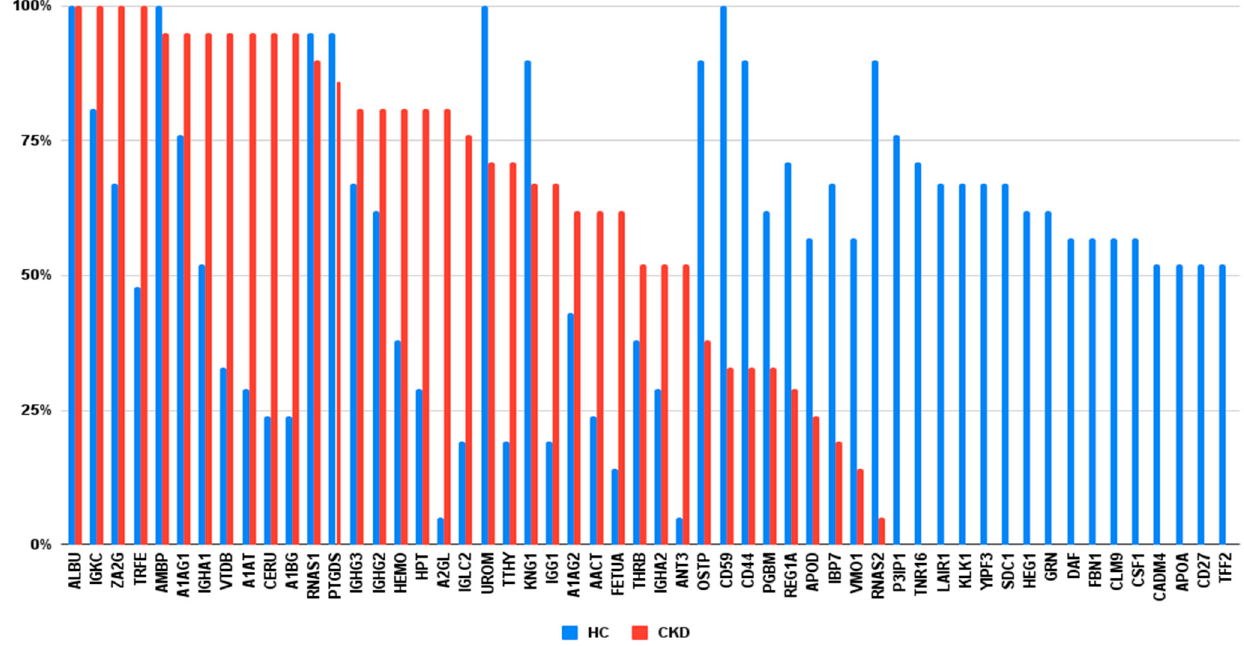
Figure 1. A comparison of protein distribution was identified in more than 50% of any group par- participants. CKD, chronic kidney disease; HC, healthy ticipants. CKD, chronic kidney disease; HC, healthy controls.